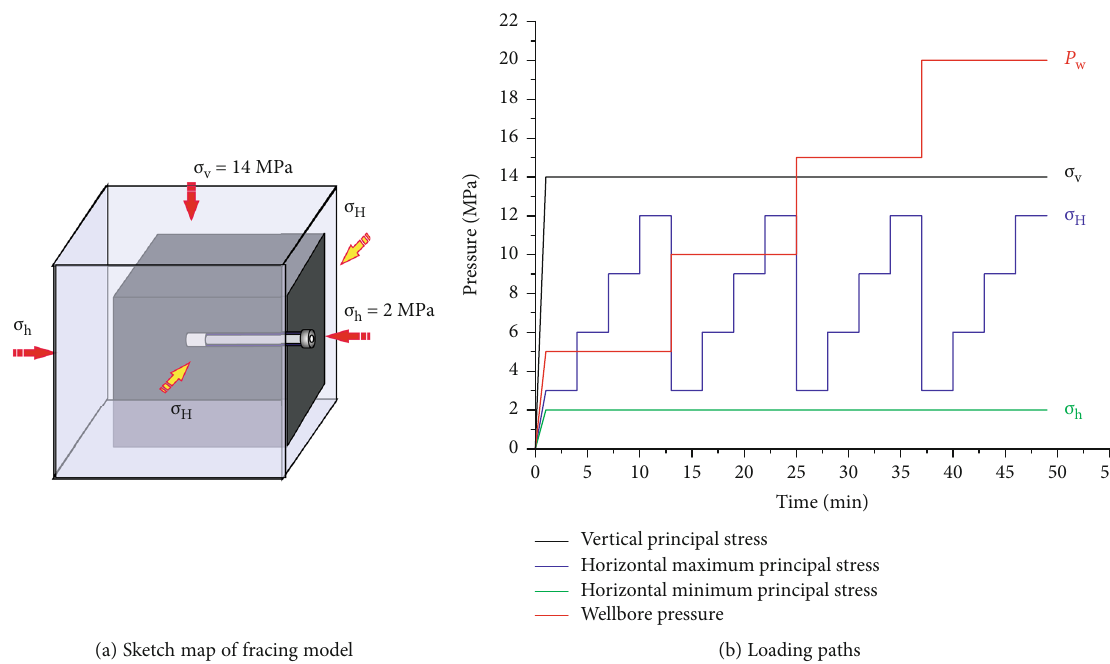
Figure 6: Scheme design for true triaxial pressurization disturbance volumetric fracing test of horizontal well (specimen B-2#).